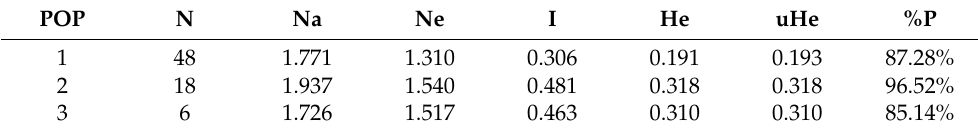
Table 1. Statistics of the genetic variation for the melon